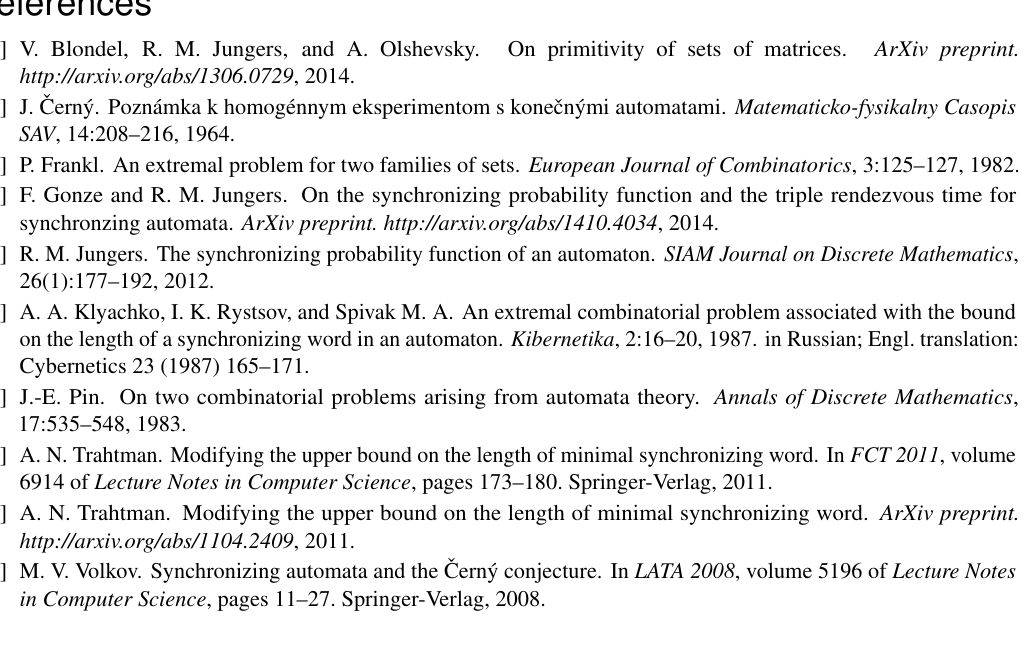
Fig. 1: A counterexample to Lemma